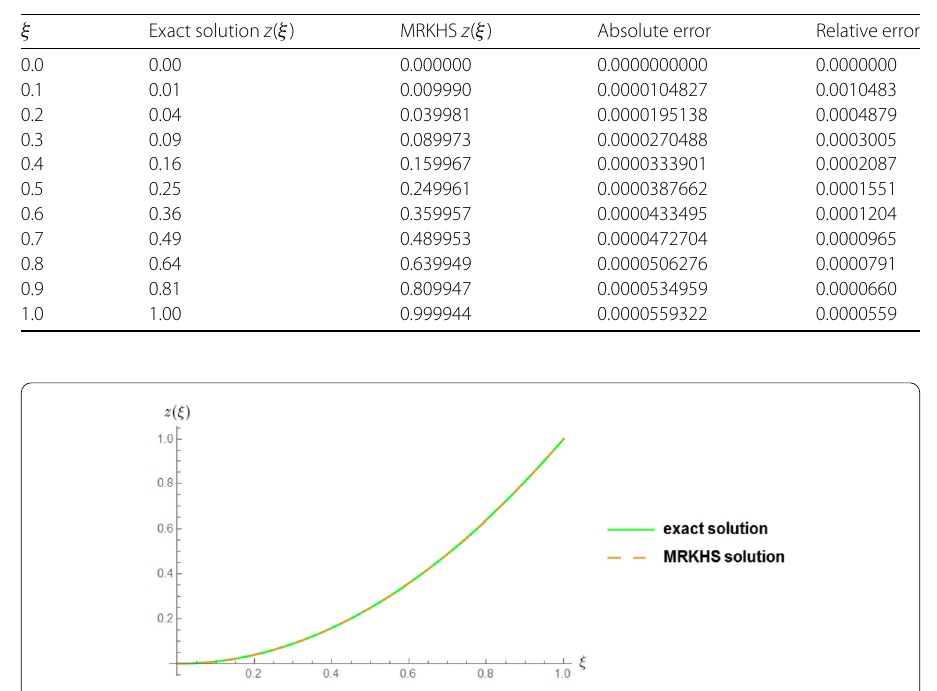
Table 3 Numerical results for Example 5.3